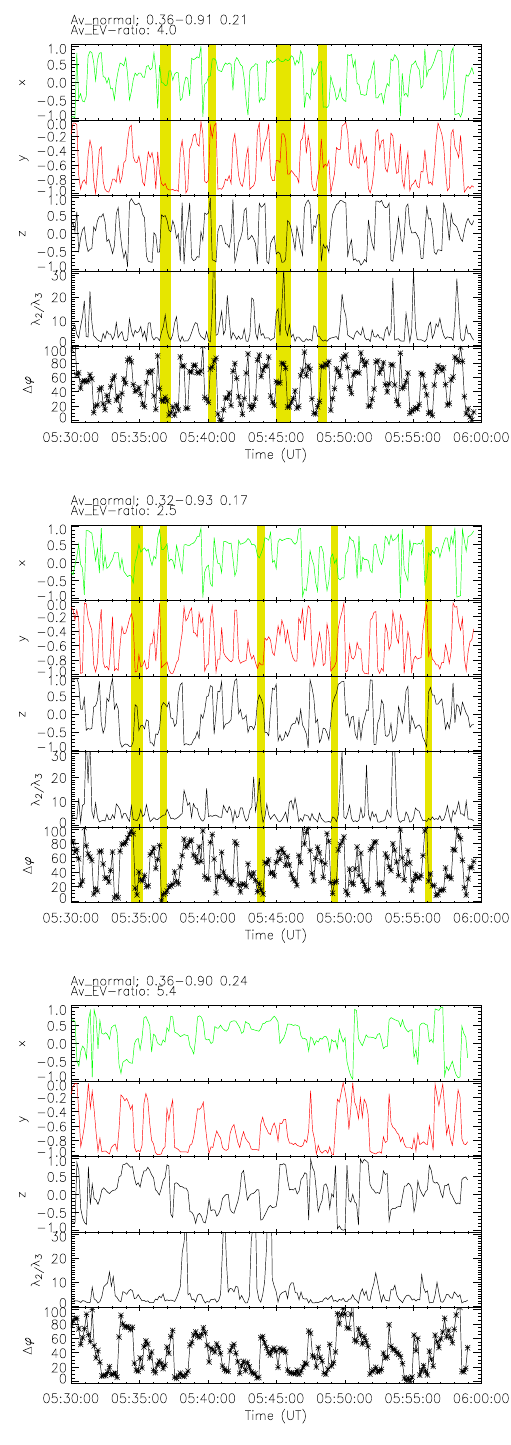
Fig. 7. Sc1 (top), sc3 (middle) and sc4 (bottom) observations between 05:30–06:00 UT of the x - (green), y - (red) and z - (black) components of the boundary normals calculated with MFR -method (top panel), eigenvalue ratios ( λ 2 /λ 3 ) of the MFR-analysis (middle panel), angle between average normal and individual normal (bottom panel). The normal calculated using 30min of data for sc1 is [0.36, − 0.91,0.21] (in GSM) with eigenvalue ratio of 4.0 and is very similar for the other 2 spacecraft (marked in upper left corner in each plot). It is pointing mostly toward the negative y -direction, which is consistent with the spacecraft crossing the dawnside magnetopause. The yellow columns show intervals where the reconnection criteria (explained later) is